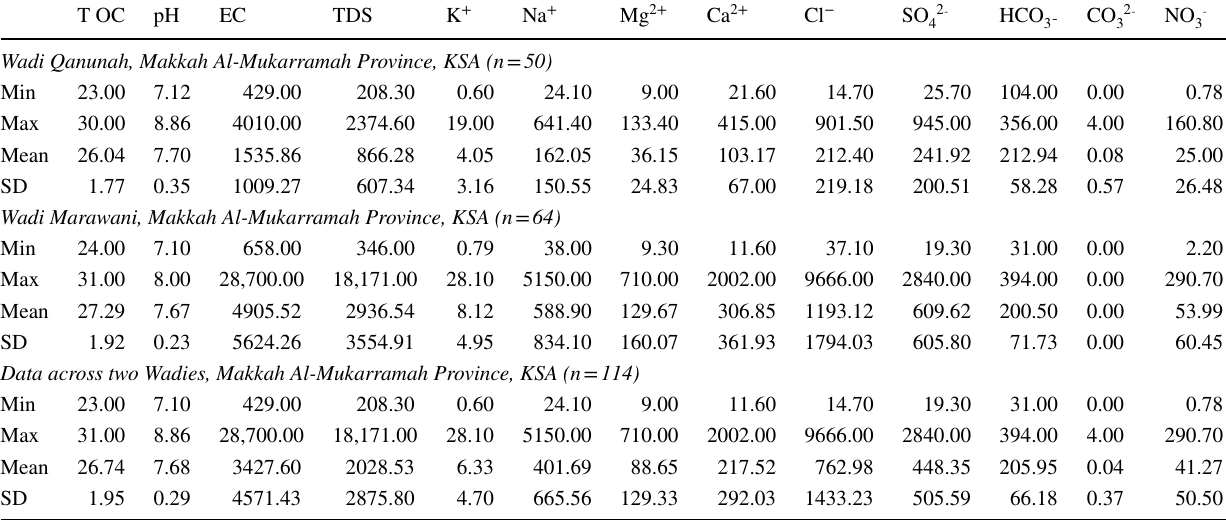
All physicochemical parameters are stated in mg/L excluding temperature (T °C), pH, and